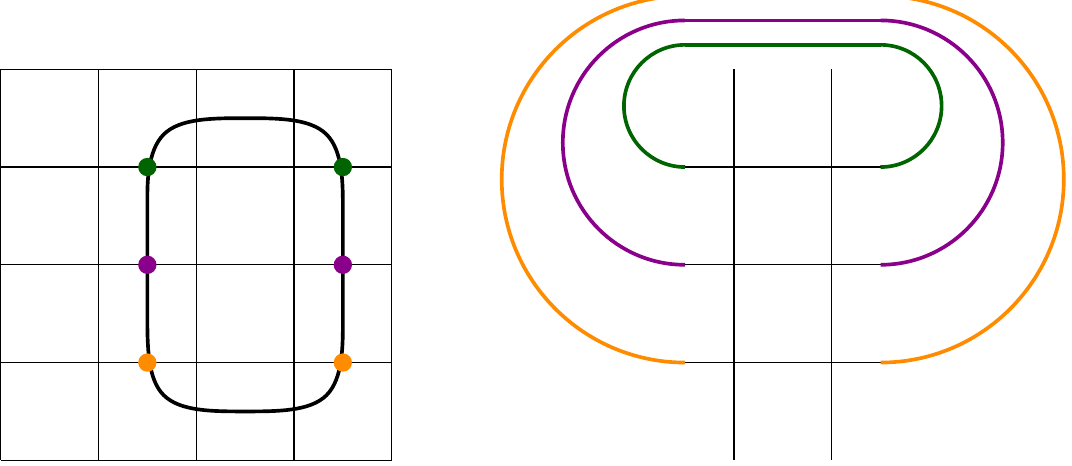
Figure 5 . An example on how to transform a path in a lattice into a diagram. Points coloured with the same color are contracted afterwards. In the lattice, horizontal lines are (cid:30) 1 , vertical lines are (cid:30) 2